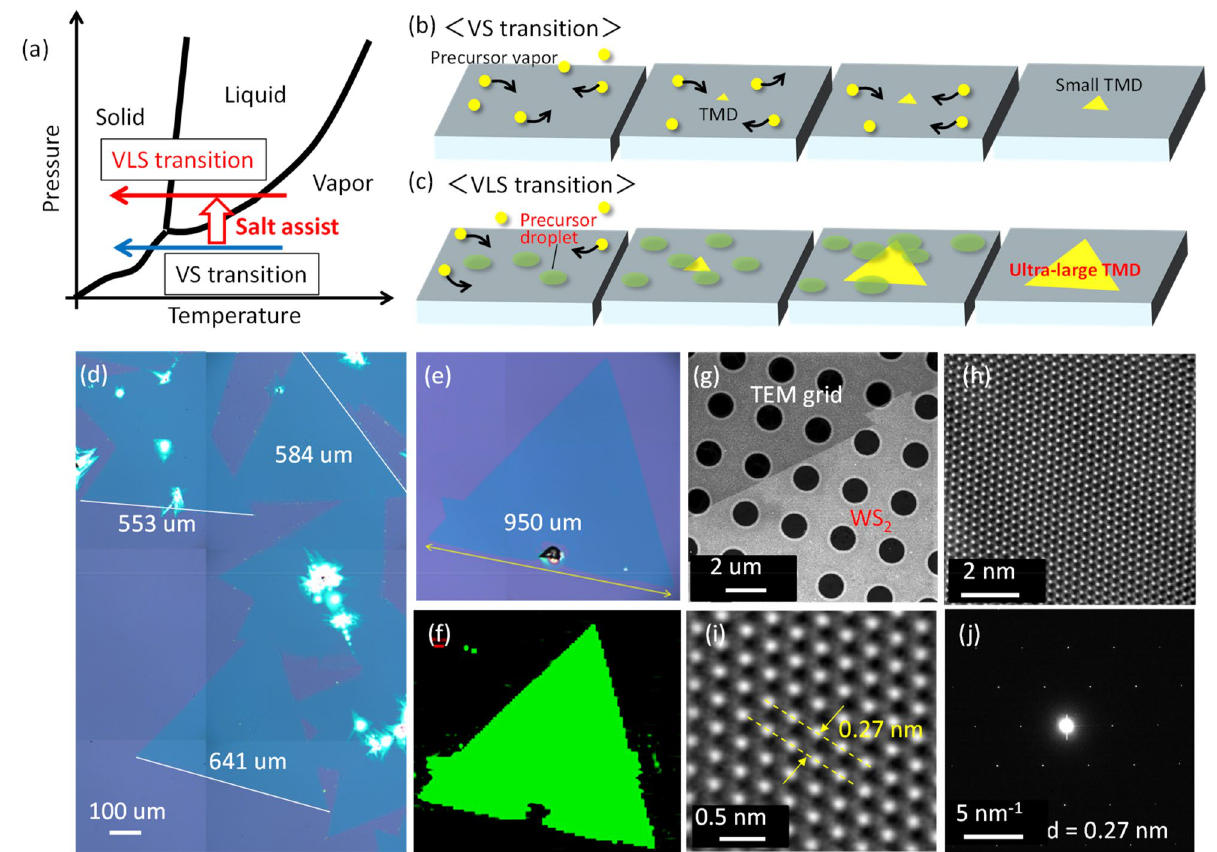
Figure 1. Comparison between VS and VLS transition. ( a ) Schematic of phase transition for non-salt assisted (VS transition) and salt-assisted (VLS transition) growth. ( b , c ) Difference of TMD growth between ( b ) VS transition and ( c ) VLS transition. ( d – h ) Typical ( d ) low and ( e ) high magnification optical microscope image, ( f ) photoluminescence (PL) mapping image, ( g ) low magnification TEM image, ( h ) low and ( i ) magnification of STEM images, ( j ) electron diffraction pattern image of monolayer WS 2 grown with our salt-assisted